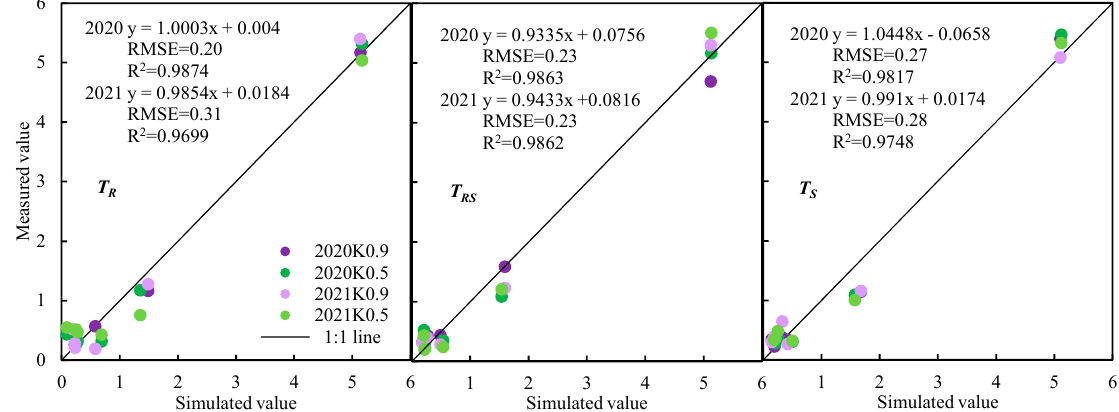
Figure 6. Comparison of simulated and measured NRLD values for greenhouse tomato under different ventilation and irrigation amounts. Table 3. Results of NRMSE statistics for simulated and measured values of NRLD.